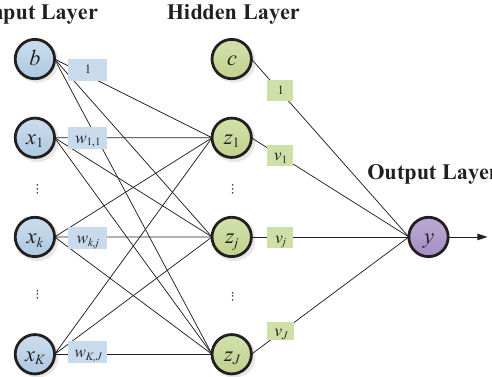
Figure 2. A typical structure of a feed-forward ANN